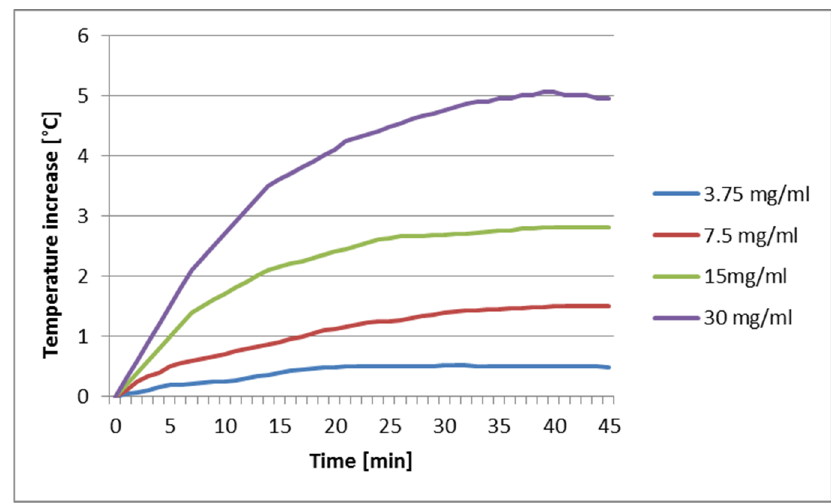
Figure 4. Plots of temperature change in time of samples 1–4 in frequency 110.2 kHz.